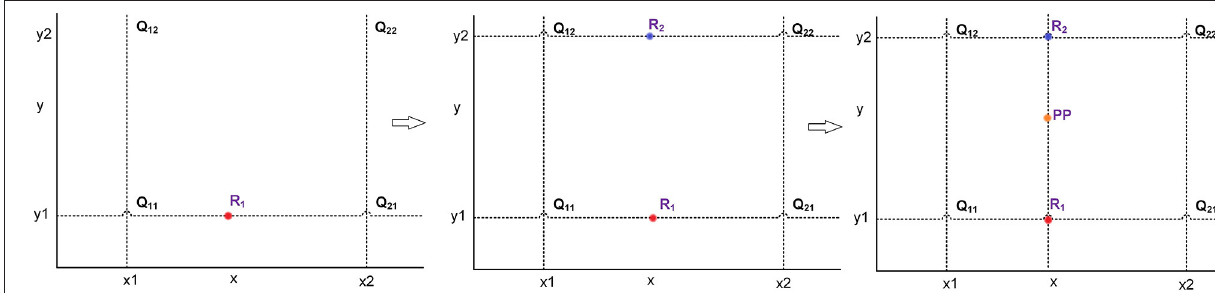
FIGURE 1 | The process of bilinear interpolation.